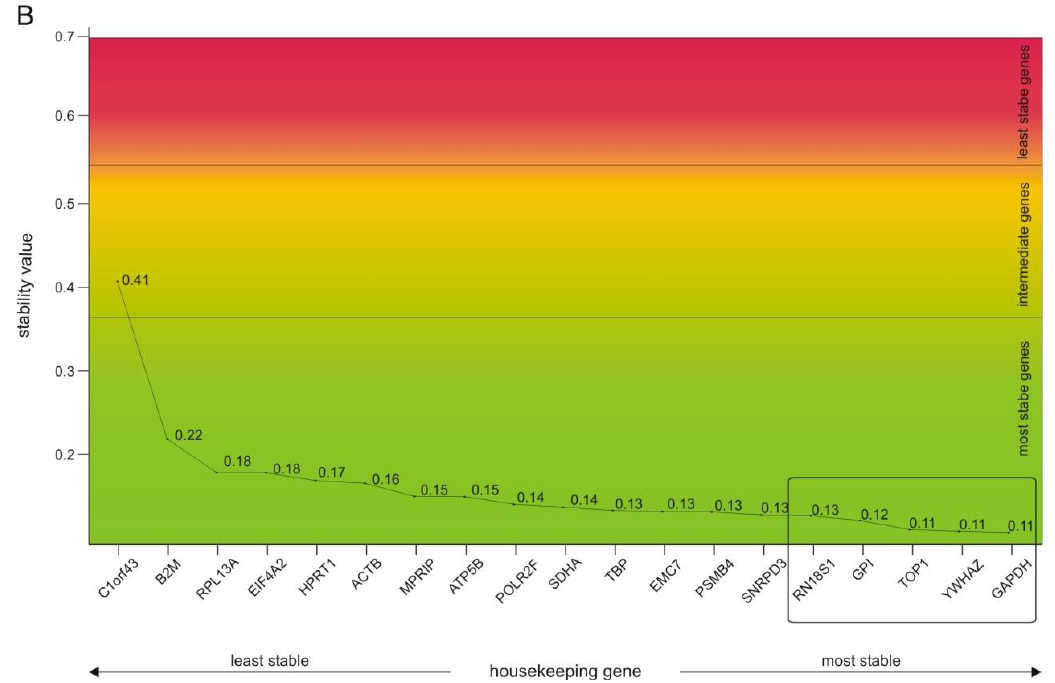
Figure 3. Selection of housekeeping genes (HKGs) for normalization in SH-SY5Y cells. ( A ) Expression levels of the selected putative HKGs given as quantitative real-time RT-PCR cycle threshold (Cq) values in SH-SY5Y cells after treatment with solvent control, caffeine, theophylline, pentoxifylline, theobromine or propentofylline. The five most stable HKGs are presented in bold letters. ( B ) Expression stability values for 19 analyzed genes calculated by the NormFinder algorithm. Classification of stability values in most stable genes (0 < stability value < 0.37; green), intermediate genes (0.37 < stability value < 0.53; yellow) and least stable genes (0.53 < stability value < 0.69; red) was done in accordance with Penna et al. [25]. HKGs are ranked from the least to the most stable from left to right and the five most stable genes selected for normalization in SH-SY5Y cells ( RN18S1 , GPI , TOP1 , YWHAZ and GAPDH ) are highlighted by a box.